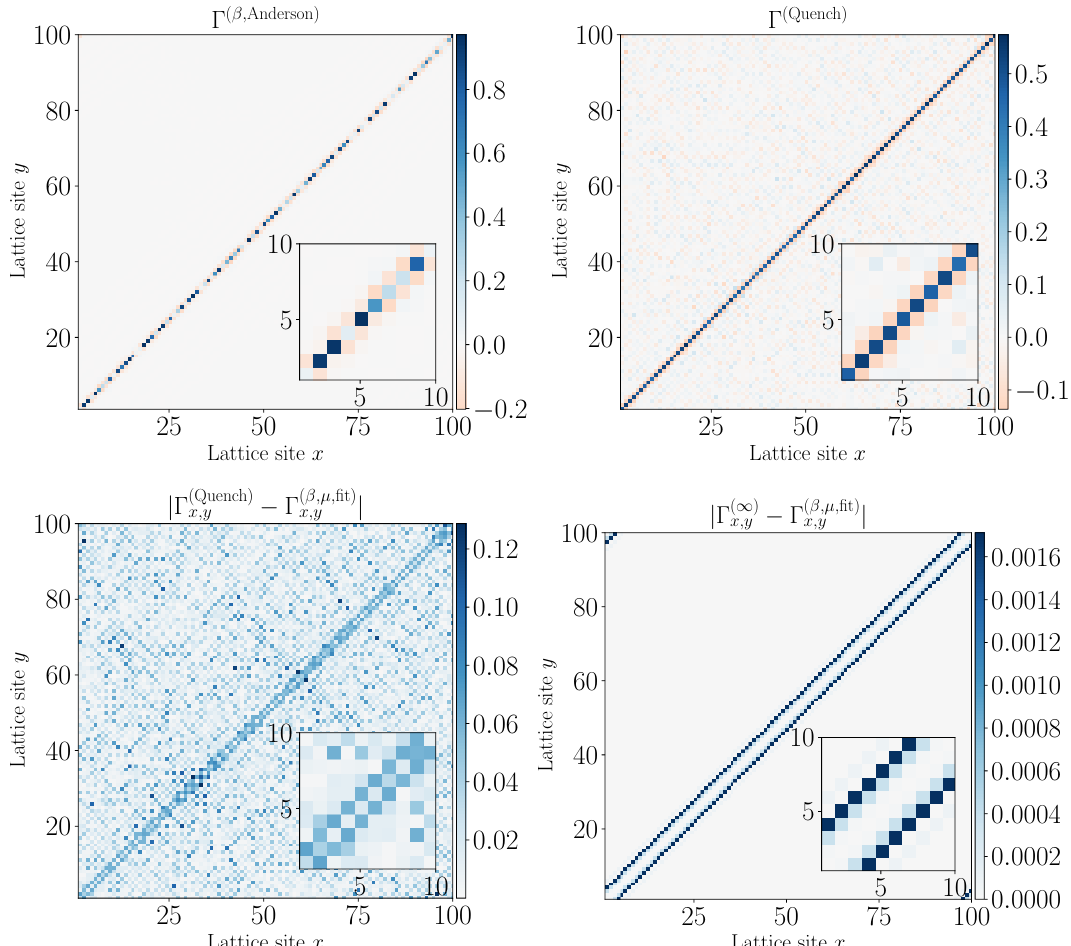
Figure 4: A system initially in a thermal state of an Anderson insulator Γ ( β ,Anderson ) with β = 1 and w = 5 (top-left) can be quenched to translation invariant evolution by switching off the on-site disorder which results in approximate translation invariance Γ ( Quench ) = Γ ( β ,Anderson ) ( t = L / 4 ) (top-right). This can be quantified with a compari- son to the thermal state of nearest-neighbour hopping Γ ( β , µ ,fit ) obtained from fitting over the temperature β and chemical potential µ (bottom-left). While deviations are seen the inverse system size L − 1 = 10 − 2 is not a stringent small parameter. However if equilibration occurs for larger systems, then it will be towards the infinite time average Γ ( ∞ ) which looks thermal at already small system sizes (bottom-right) and this property is retained when going towards the thermodynamical